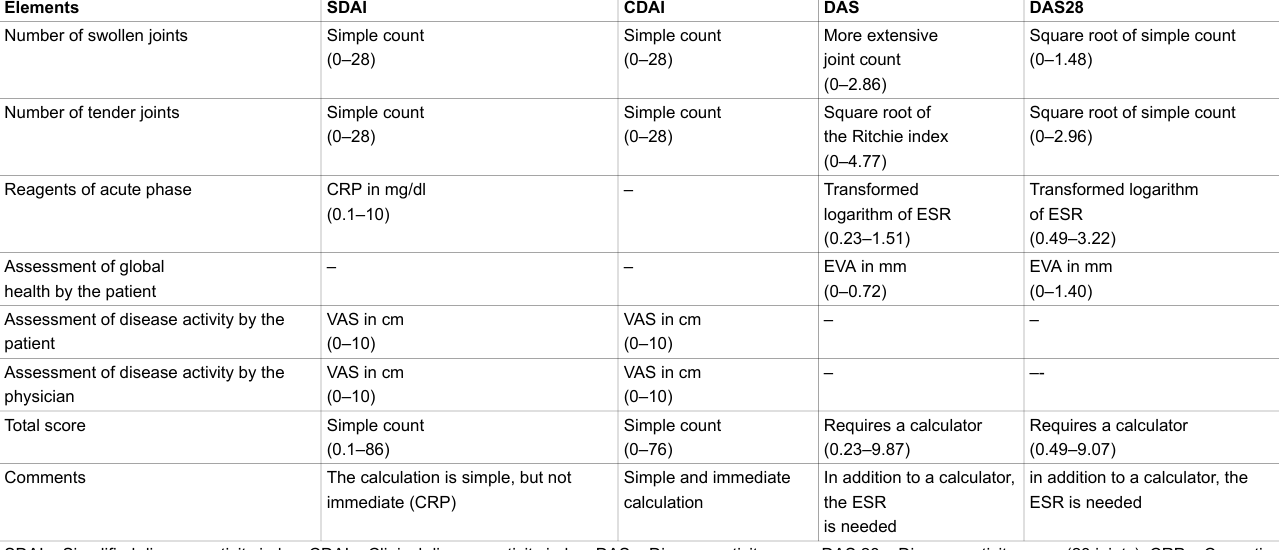
Table 1 Characteristics of the composite indices of activity of rheumatoid arthritis: elements and contribution to the total score. Elements